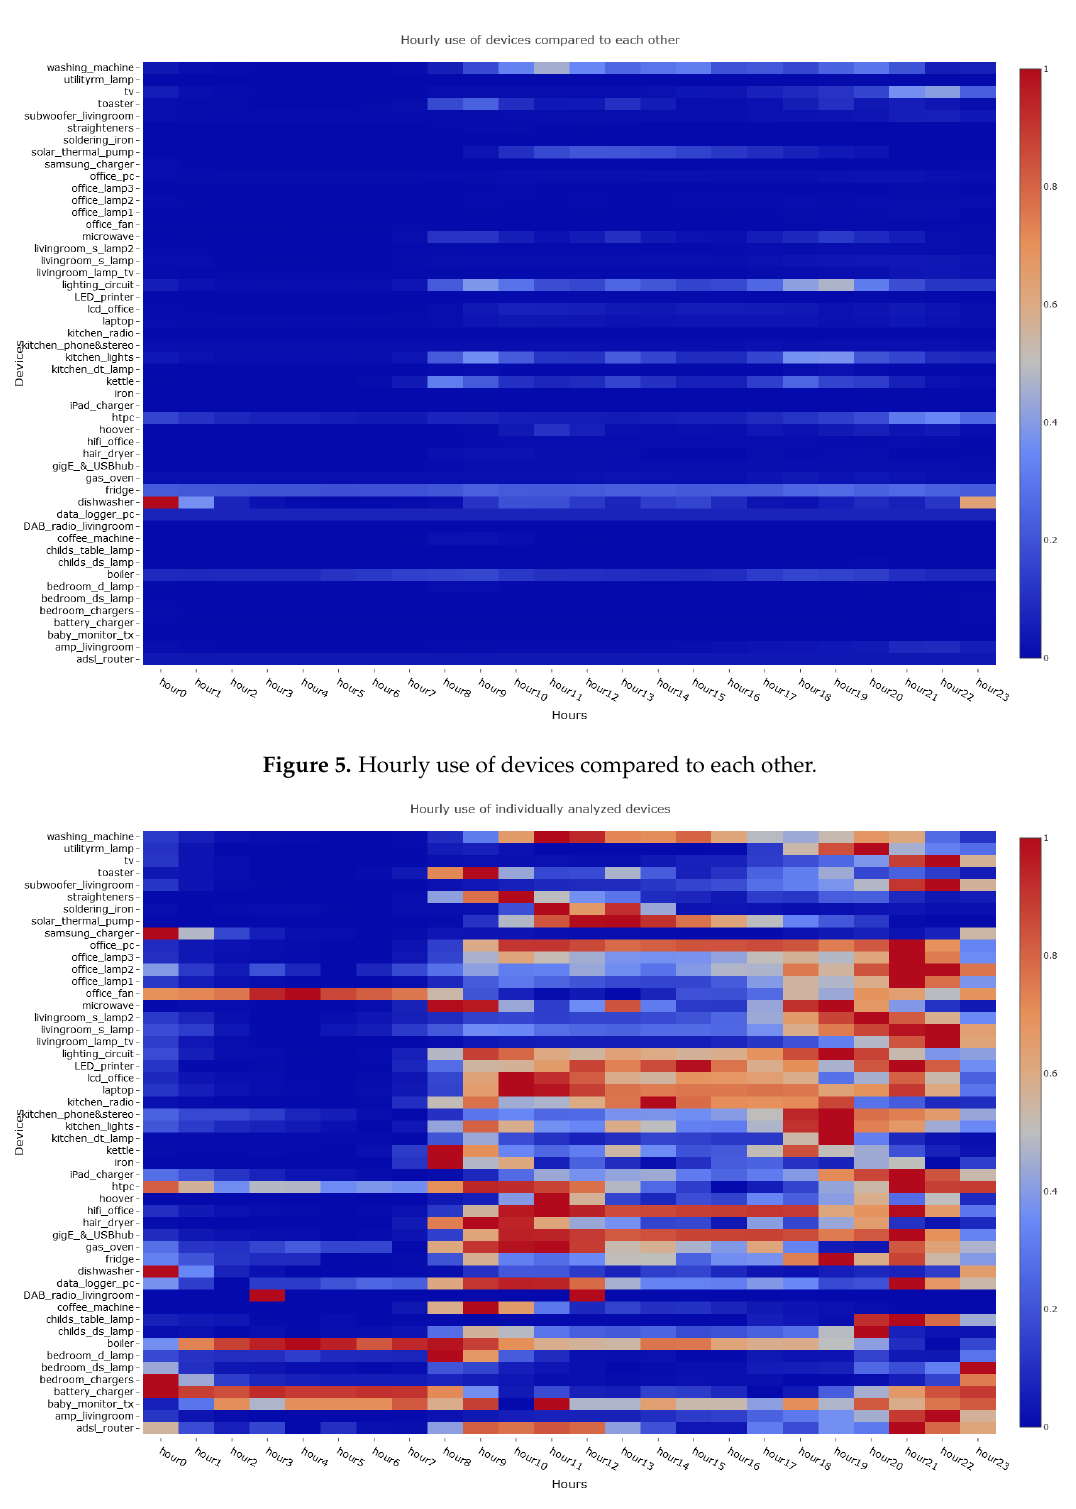
Figure 6. Hourly use of individually analyzed